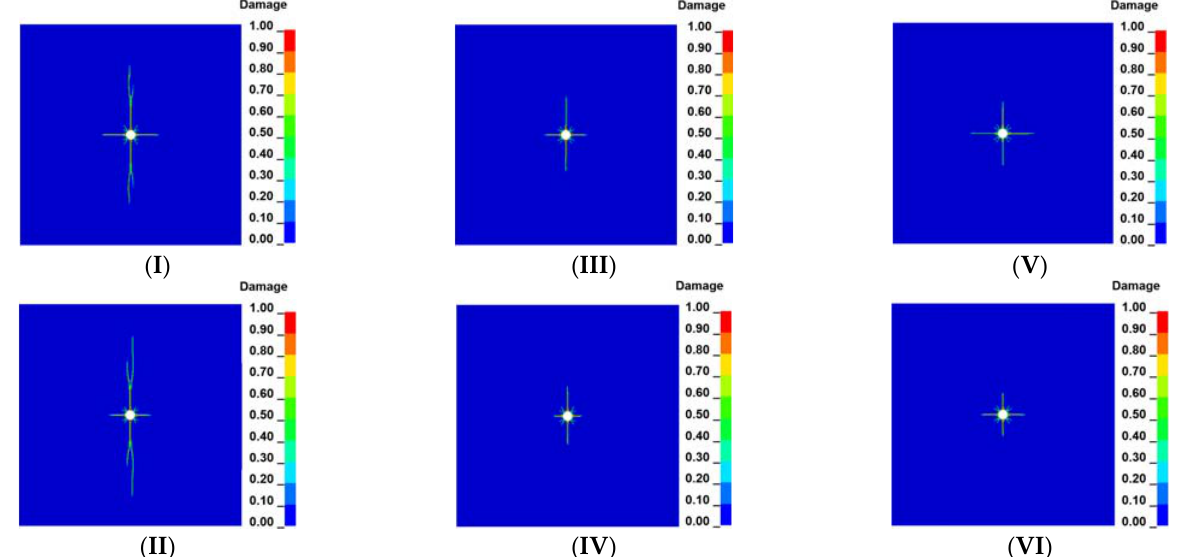
Figure 10. Crack propagation under different in-situ stresses: ( I ) Px = 0, Py = 2; ( II ) Px = 0, Py = 4; ( III ) Px = 2, Py = 4; (I V ) Px = 3, Py = 6; ( V ) Px = 2, Py = 2; ( VI ) Px = 4, Py = 4.